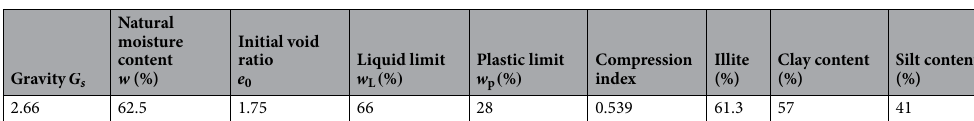
Table 2. Basic physical and mechanical properties of soft